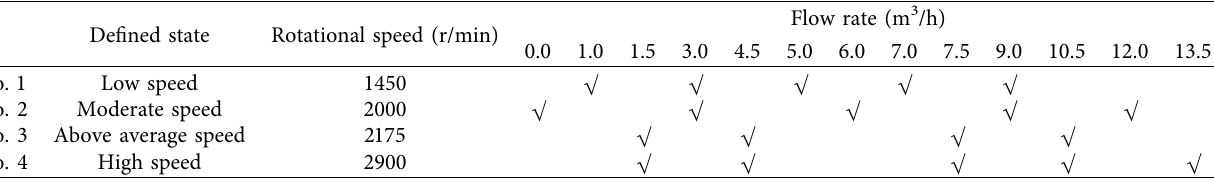
Table 2: Test scheme.